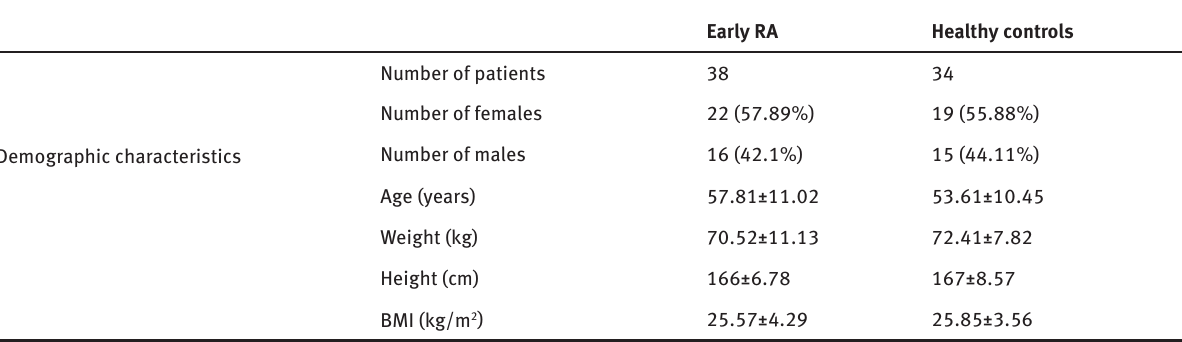
Table 1. Demographic characteristics of patients with early RA and healthy